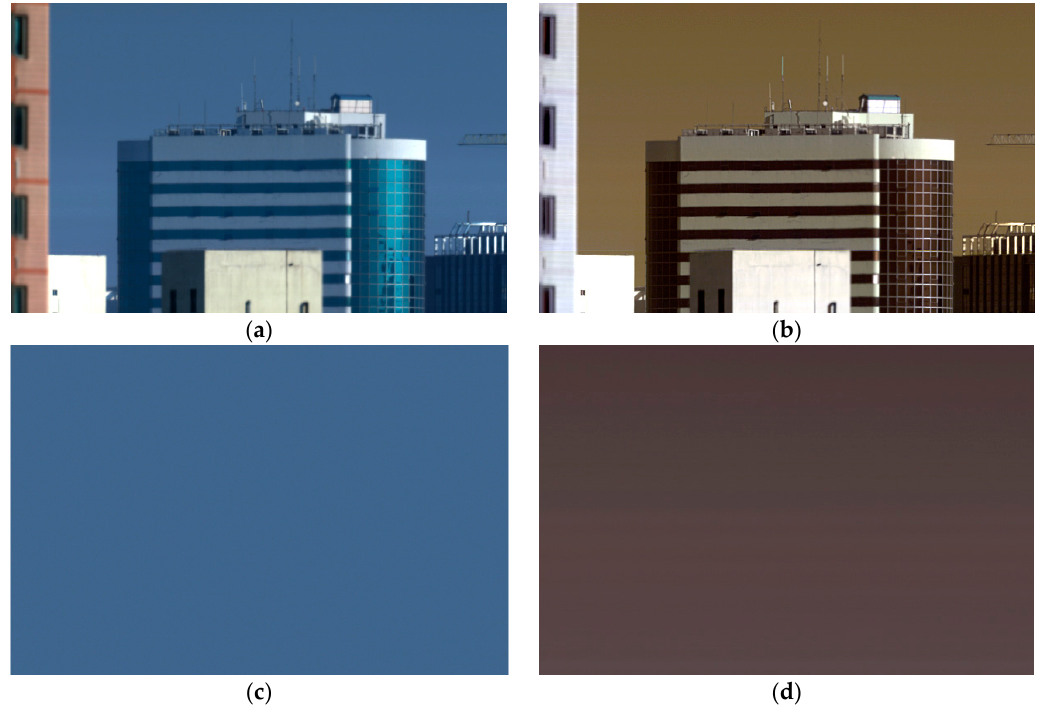
Figure 15. Correction results of the ground data using the proposed method. ( a ) A sub-image of “buildings” in visible bands (R: 650 nm, G: 560 nm, B: 480 nm); ( b ) A sub-image of “buildings” in NIR bands (R: 740 nm, G: 825 nm, B: 955 nm); ( c ) A sub-image of “the sky” in visible bands (R: 650 nm, G: 560 nm, B: 480 nm); ( d ) A sub-image of “the sky” in NIR bands (R: 825 nm, G: 912 nm, B: 976 nm).